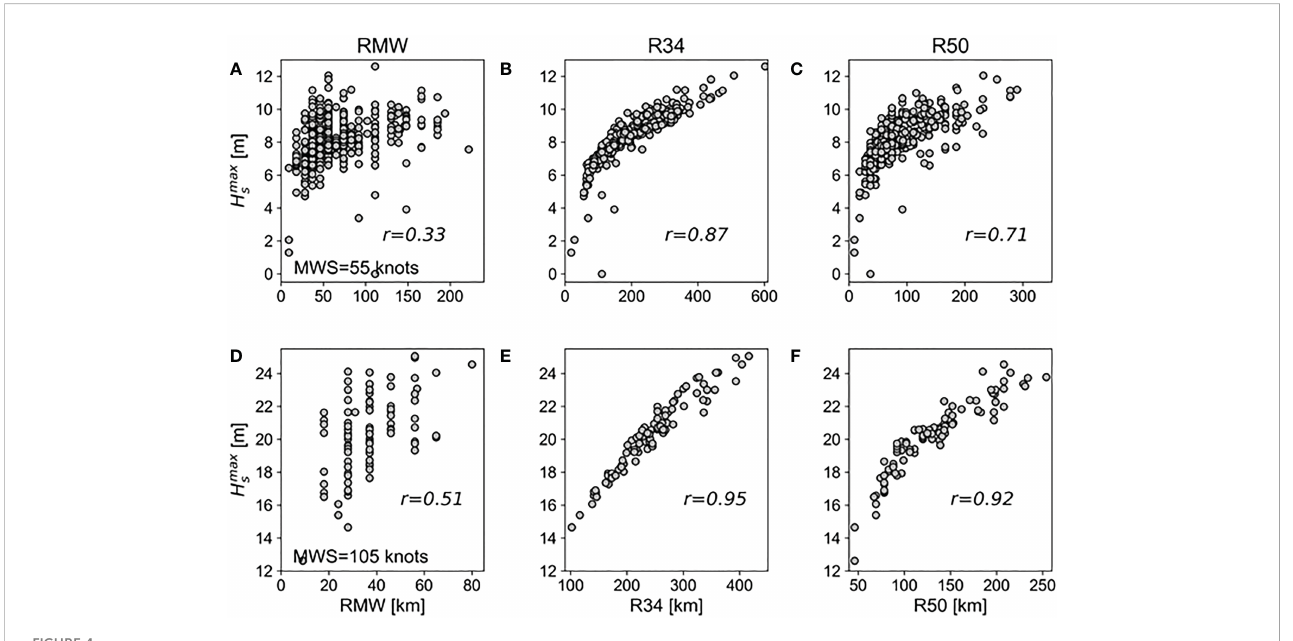
FIGURE 4 Same as in Figure 3 but V fm is 7.875 m s -1 . RMW (A, D) , R34 (B, E) , and R50 (C, F)